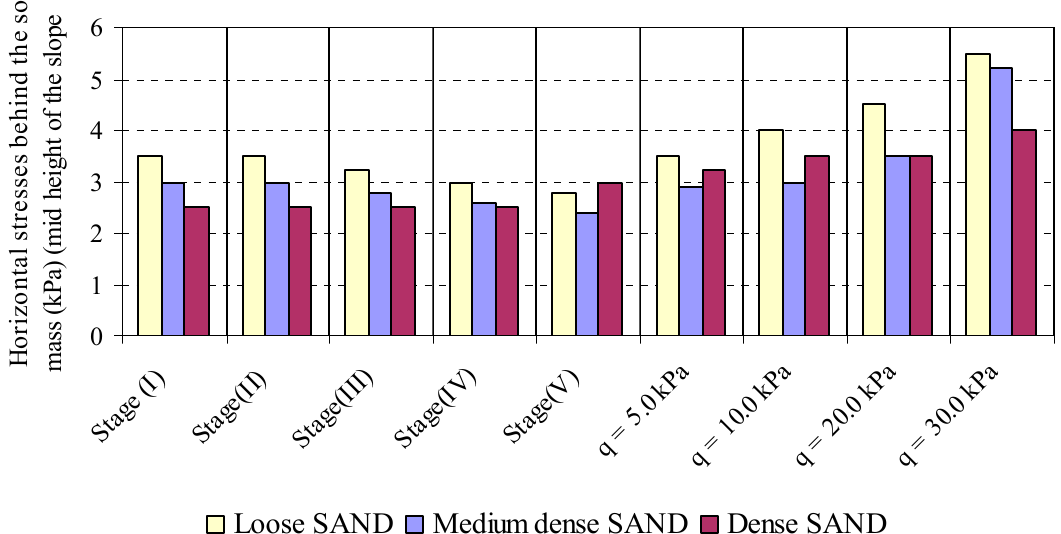
Figure 10. Influence of soil density on horizontal stresses behind the nailed soil mass at mid-height of slope.